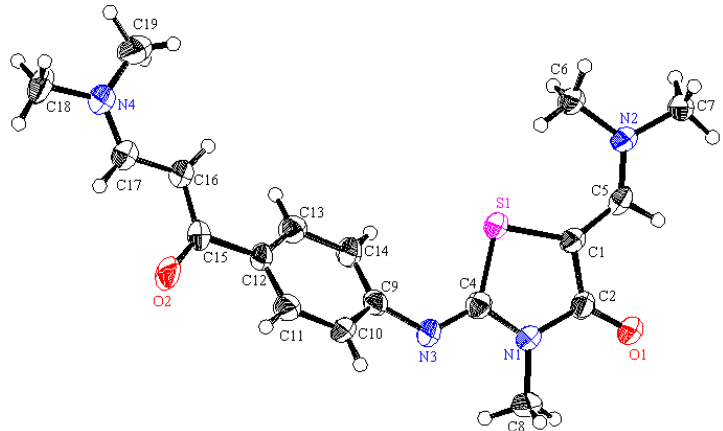
Figure 7. ORTEP plot of the X-ray crystallographic data determined for 11 . Crystallo- graphic data have been deposited with the Cambridge Crystallographic Data Centre as supplementary publication number CCDC 880545